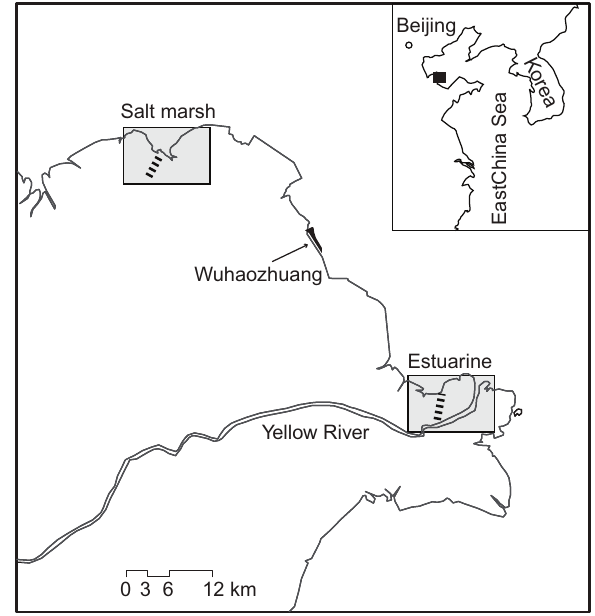
Figure 1. Map showing study sites in the Yellow River Delta, northern China. Cordgrass was artificially planted at Wuhaozhuang in the 1980s, and has invaded the estuarine site. Cordgrass was collected at Wuhaozhuang and transplanted into different zones (along the dotted lines) at the salt marsh and estuarine sites.